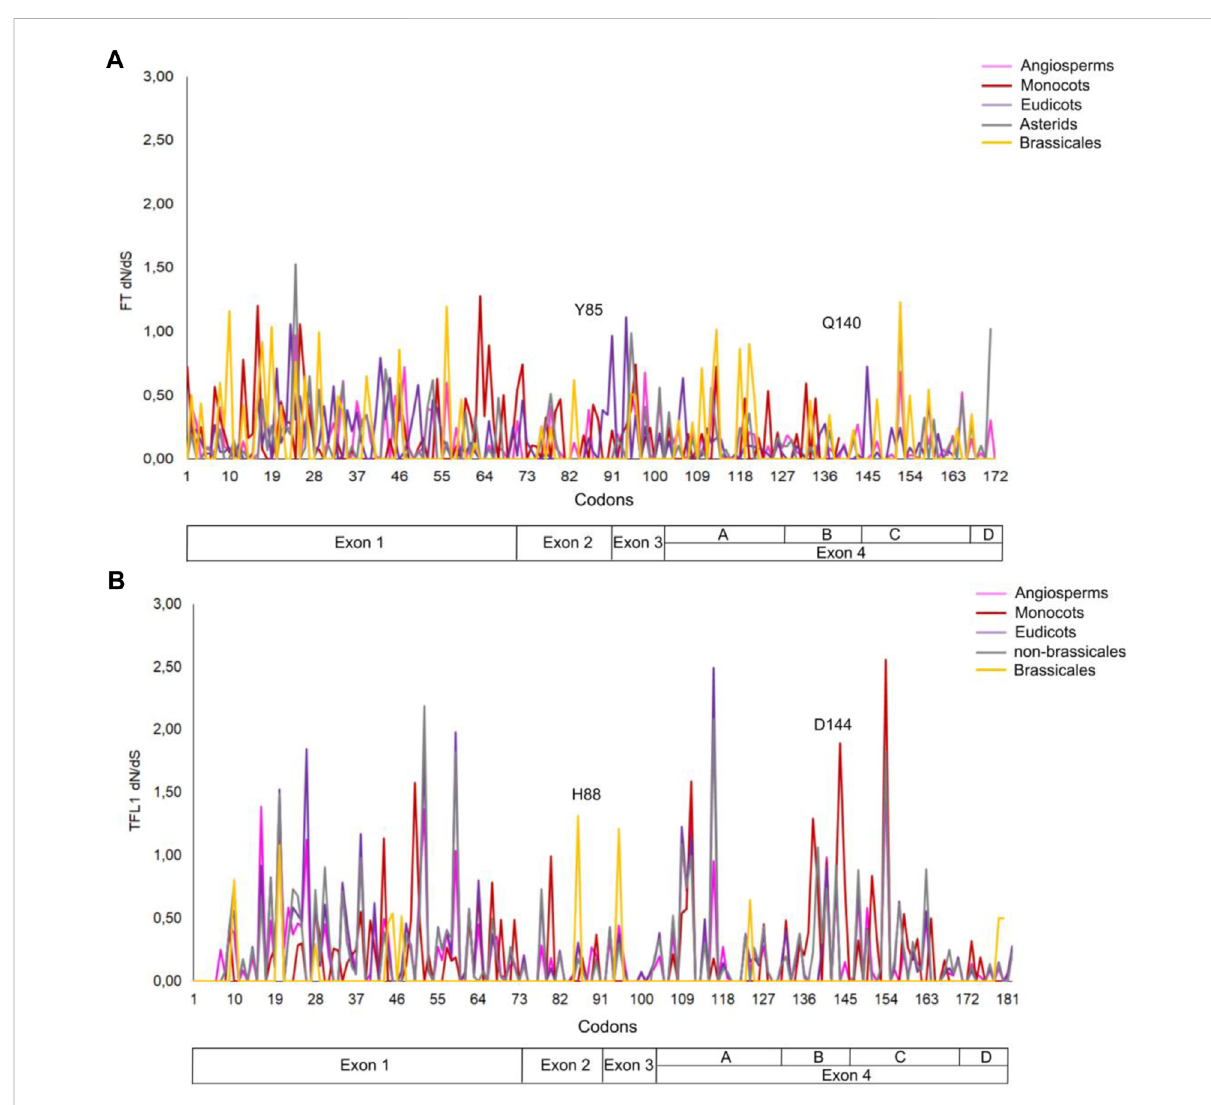
FIGURE 8 Analysis of the selective pressures indicated by dN/dS rates of the codons for FT (A) and TFL1 genes (B)